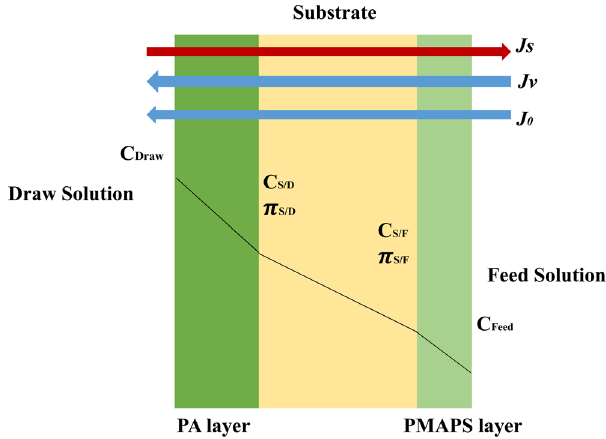
Figure 3. Concentration profile of double-skinned